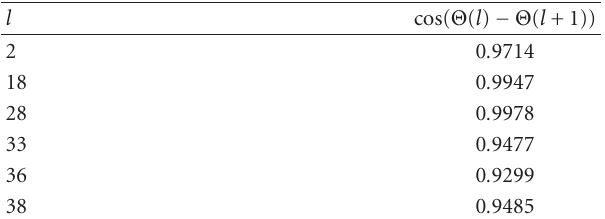
Table 3: Mean angle correlation of WMAP data in Galactic coordi- nate.